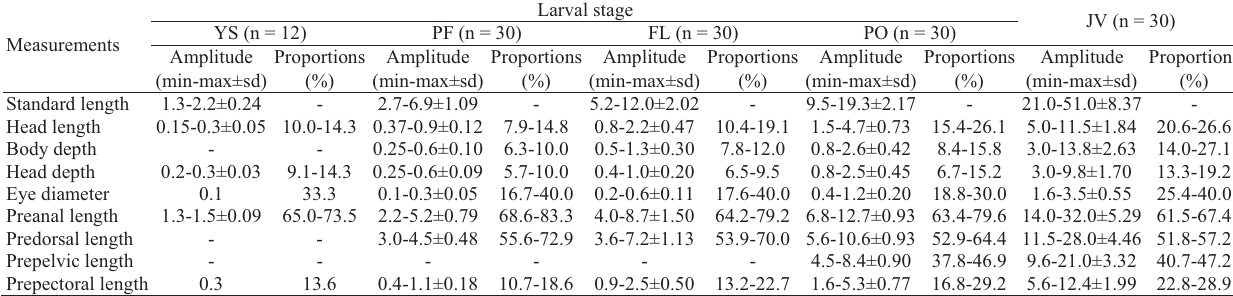
Table 2. Morphological data for Anchoviella vaillanti larvae in the yolk-sac (YS), preflexion (PF), flexion (FL), postflexion (PO) stages and juvenile period (JV). All proportions are related to standard length, except for eye diameter, in relation to head length. Amplitude expressed in mm, as minimum-maximum values±sd (Standard